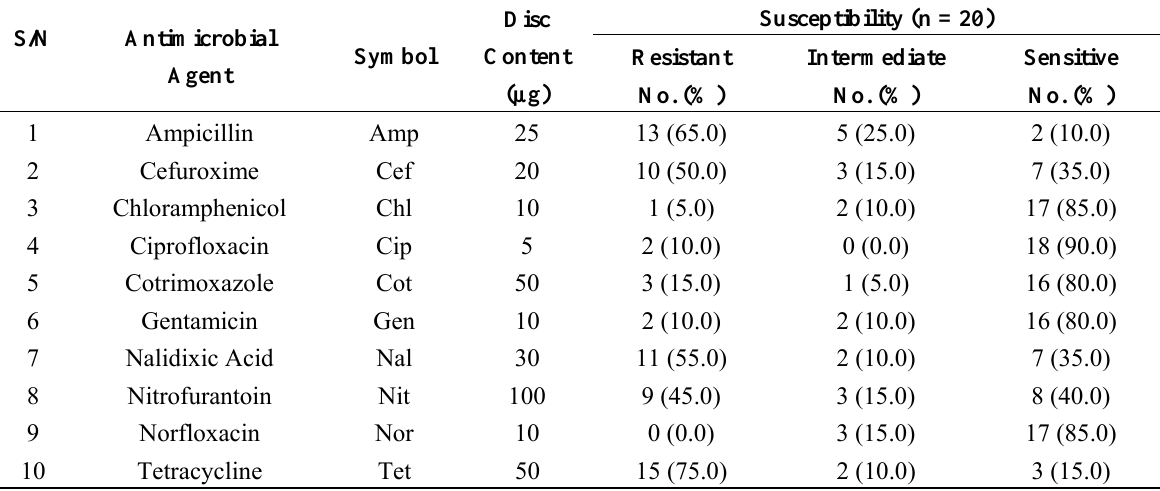
Table 4. Antimicrobial susceptibility pattern of E. coli O157 strains isolated from clinical and water